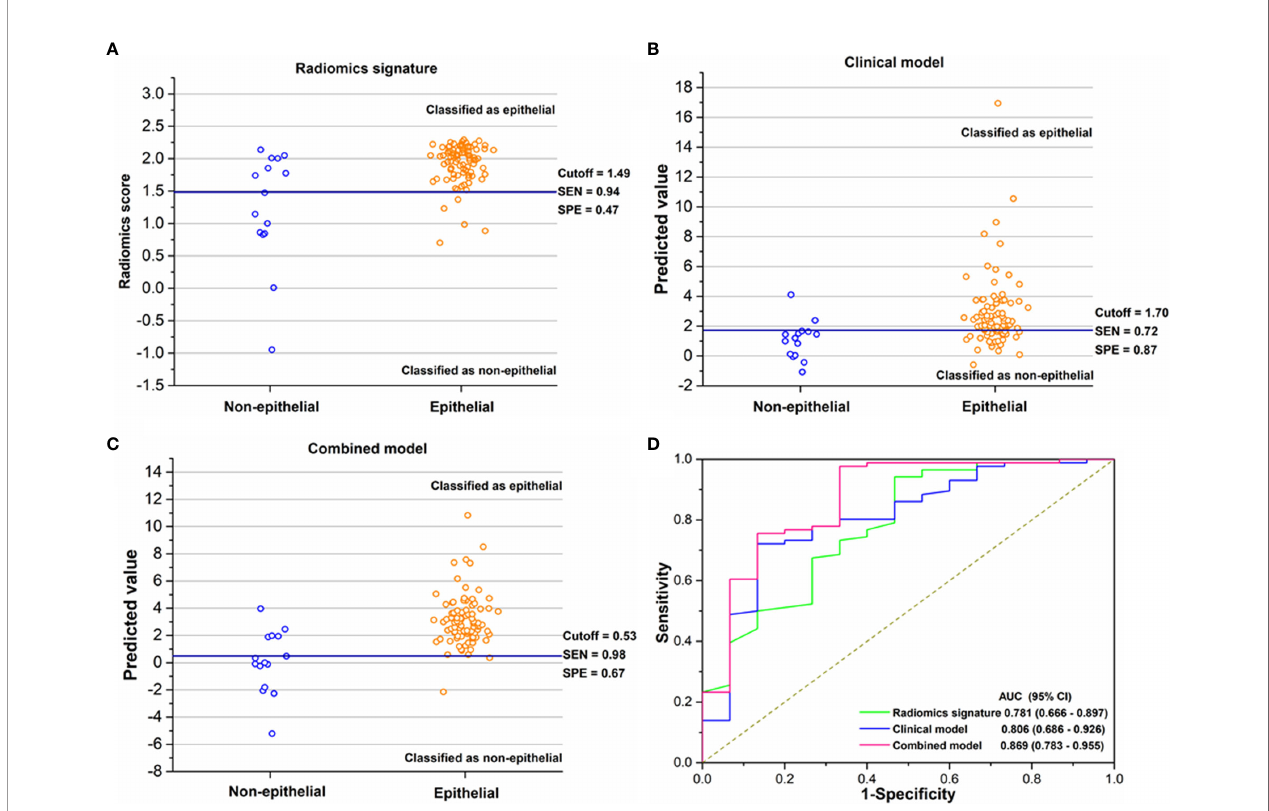
FIGURE 3 | (A – C) The performance of the radiomics signature, clinical model, and combined model for the discrimination of histological subtypes in each patient. The blue solid line indicates the best cutoff of the radiomics score or the predicted value of two models for the discrimination of histological subtypes; patients above the cutoff were classi fi ed as epithelial group, while patients below the cutoff were classi fi ed as non-epithelial group. (D) The receiver operating characteristics (ROC) curves with area under curves (AUCs) for radiomics signature, clinical factor model, and combined model of 0.781 (95% CI, 0.666 – 0.897), 0.806 (95% CI, 0.686 –